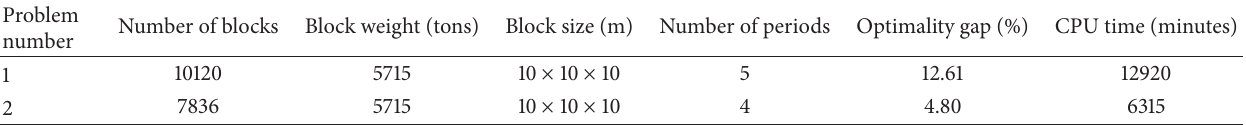
Table 1: General information about the blocks within UPL and optimization